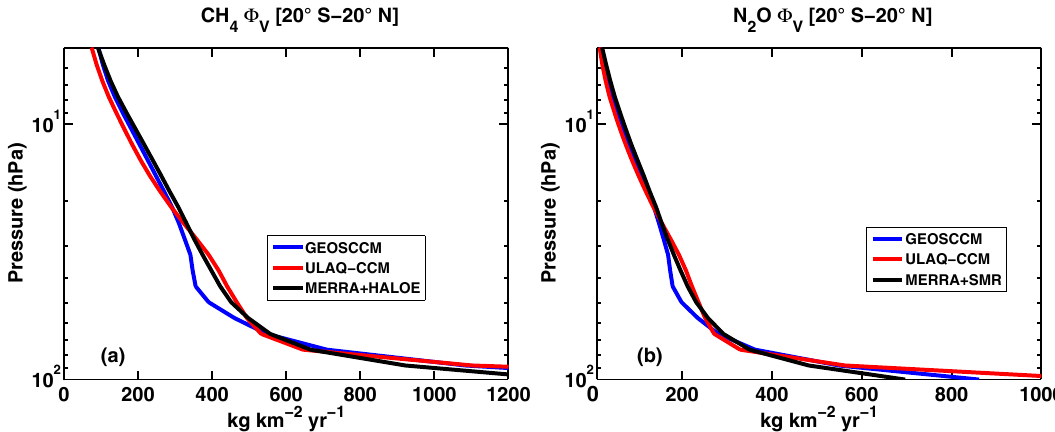
Figure 2. Tropical stratospheric vertical mass fluxes (20 ◦ S–20 ◦ N) of (a) CH 4 and (b) N 2 O for GEOSCCM (blue) and ULAQ-CCM (red) results; the vertical mass fluxes are defined as [ ρw ∗ ], where w ∗ is the zonal mean residual vertical velocity and ρ is the zonally averaged mass concentration of CH 4 and N 2 O, respectively. A model evaluation is made with flux data obtained with w ∗ from MERRA reanalysis and CH 4 , N 2 O mixing ratios from HALOE and SMR results (black) (kgkm − 2 yr − 1 ). CH 4 and N 2 O fluxes are averaged over 1991–2005 and 2001–2005, respectively, to keep consistency with the adopted HALOE and SMR mixing ratio